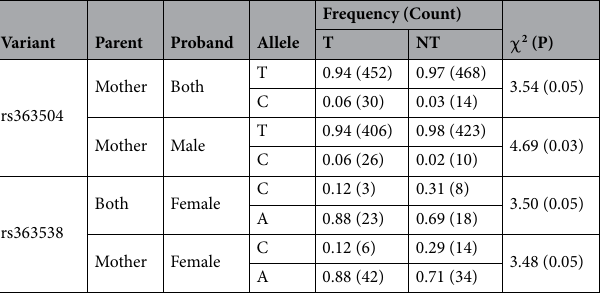
chiefly to the male probands ( P = 0.03; RR = 0.40, CI = 0.20–0.77; Power 58%) (Table 2). Biased transmission of the rs363538 ‘A’ allele was also observed in the female probands ( P = 0.05; RR = 0.32, CI = 0.09–1.21; Power 46%) from both the parents as well as the mother ( P = 0.05; RR = 0.37, CI = 0.14–0.98; Power 46%) (Table 2). Quantitative trait analysis. Genotype–phenotype association analysis (Table 3) revealed a positive influ- ence of the rs363504 ‘T’ allele ( P = 0.05, Add Value = 0.01) and ‘TT’ genotype ( P = 0.04, Add Value = 0.01) on the hyperactivity (HA) score measured using the Conners Parent and Teacher Rating Scale-Revised (CPRS-R). No significant association was detected for other traits assessed by the CPRS-R (Supplementary Table S2). rs363504 ‘T’ allele also showed positive influence (Table 3) on the oppositional defiant disorder (ODD; Add Value = 0.06; P = 0.005) and Parental Account of Children’s Symptoms (PACS; Add Value = 0.10; P = 0.003) scores. Probands with genotypes having the “T” alleles (Table 3) also showed higher scores for ODD ( P < 0.02, AddValue = 12.6) and PACS ( P < 0.007, Add Value = 16.03). Scores for Diagnostic and Statistical Manual-Hyperactivity/Impulsivity (DSM-HI) were higher in the presence of the rs363538 ‘A’ allele ( P = 0.04, Add Value = 0.05) and ‘AA’ genotype ( P = 0.01, Add Value = 0.07), while the traits scores ( P = 0.008, Add Value = −0.08) were reduced in the presence of the ‘CA’ genotype (Table 3). The other Table S2). Probands harbouring the ‘CC’ ( P = 0.05, Add Value = 19.67) and ‘CA’ ( P = 0.02, Add Value = 0.64) genotypes showed higher IQ scores (Table 3). The presence of the ‘T-C’ haplotype, formed by rs363504–rs363538, lowered the score for DSM-HI ( P = 0.03), whereas the ‘C-A’ haplotype had a negative impact on ODD ( P = 0.005) and PACS ( P = 0.01) scores (Table 3).